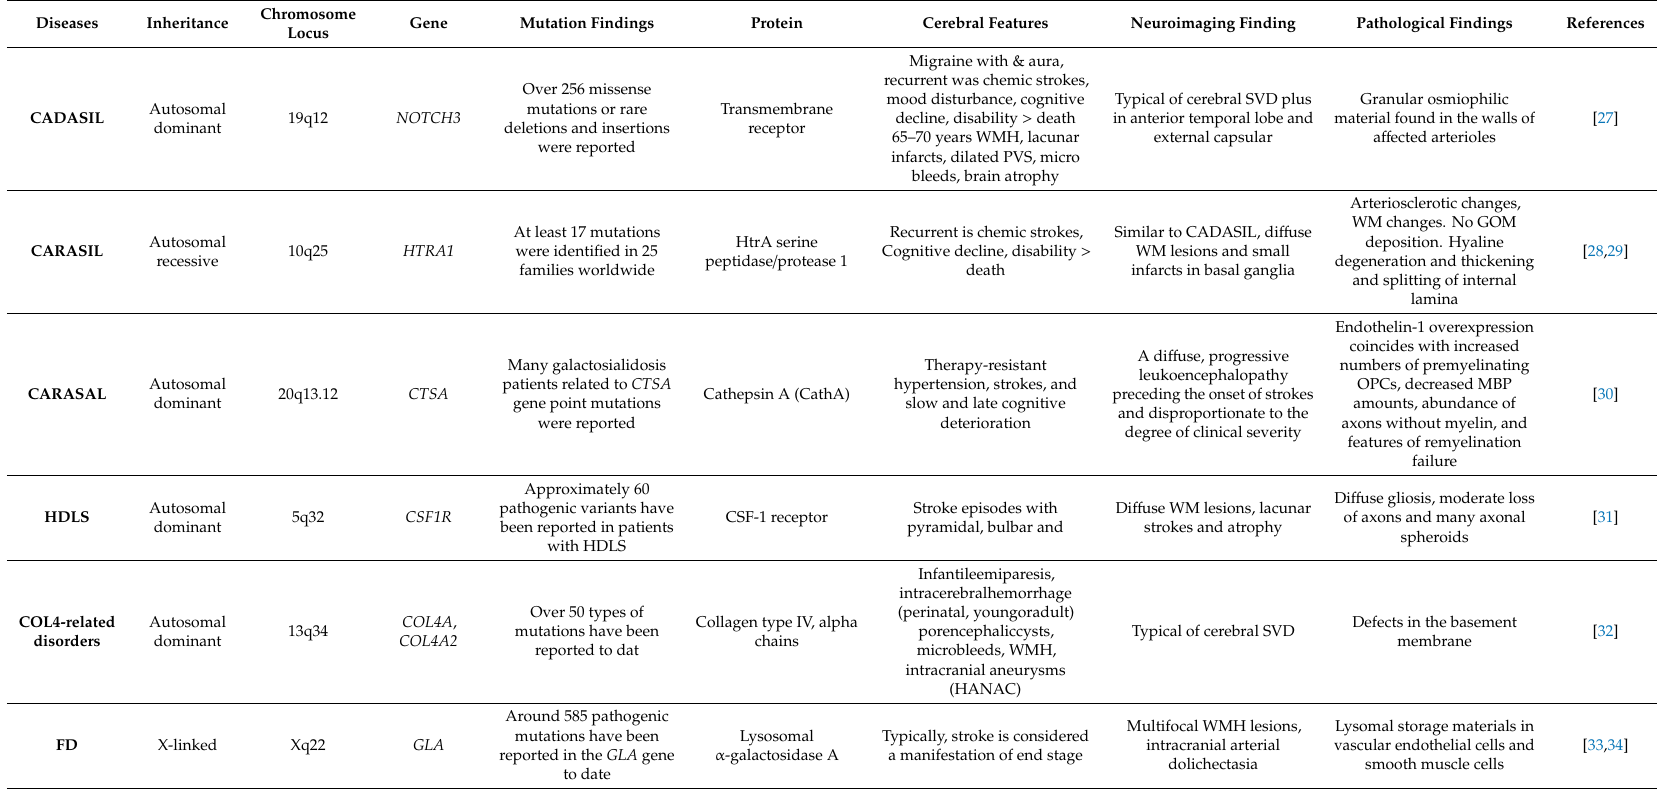
Table 1. Characteristics of single-gene disorders causing cerebral